Question: What kind of plot is shown here?
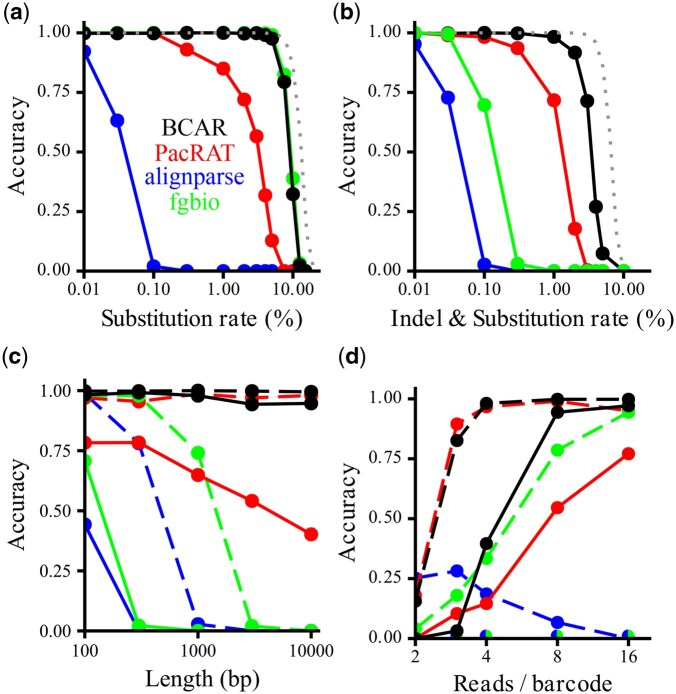
Answer: line